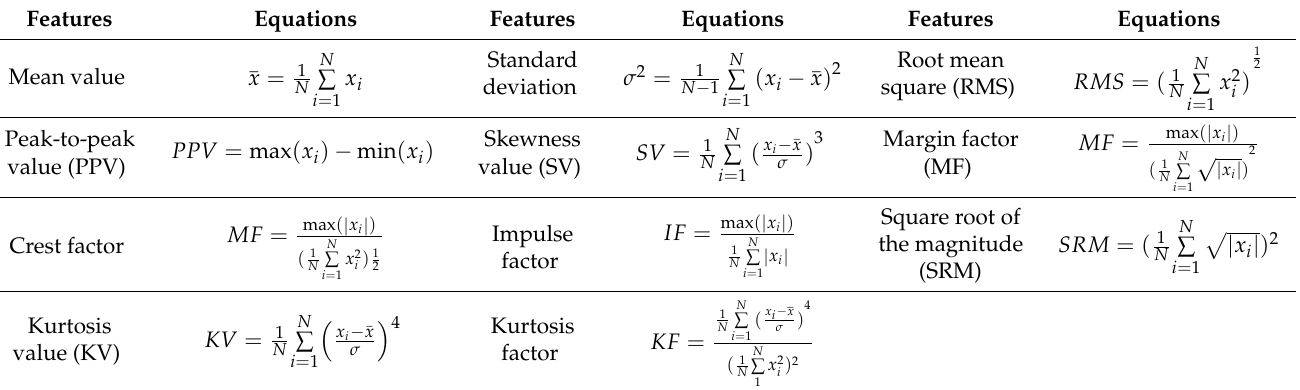
Table 2. The statistical features used in this